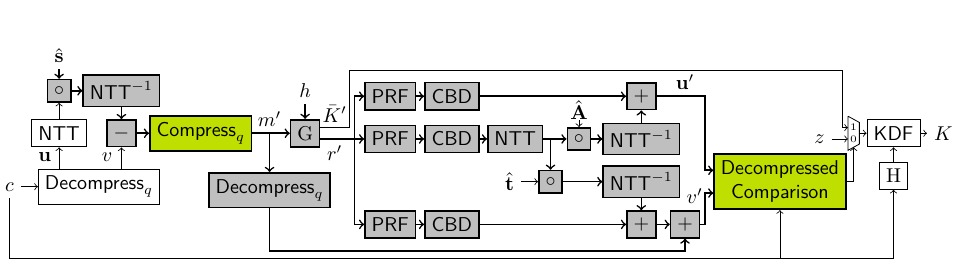
Figure 1: An overview of the various components in the Kyber CCA decapsulation. The components which need to be protected / masked are in color (gray or green) where we present new approaches for the green